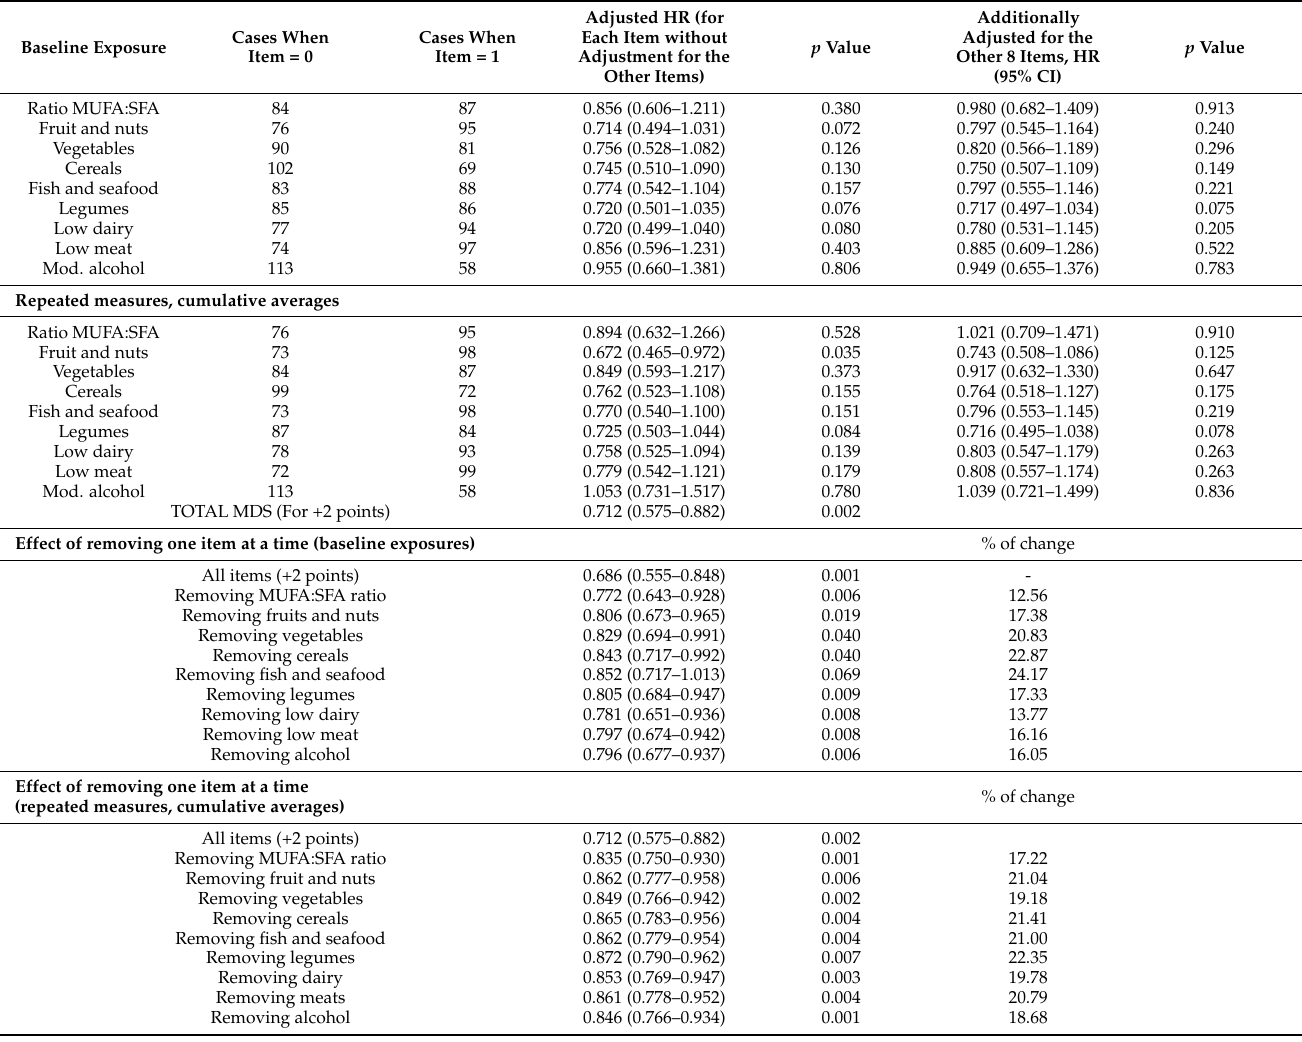
Table 3. Hazard ratios (95% confidence intervals) for each component of the MDS (yes/no) and effect of removing each component of MDS (one at a time) in the HR of CVD for the equivalent to +2 points in MDS in the “Seguimiento Universidad de Navarra” (SUN) cohort,